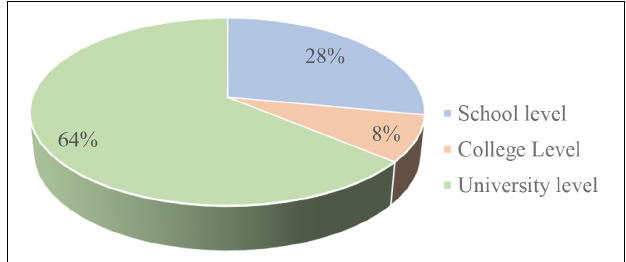
FIGURE 2 | Distribution of articles by educational levels.